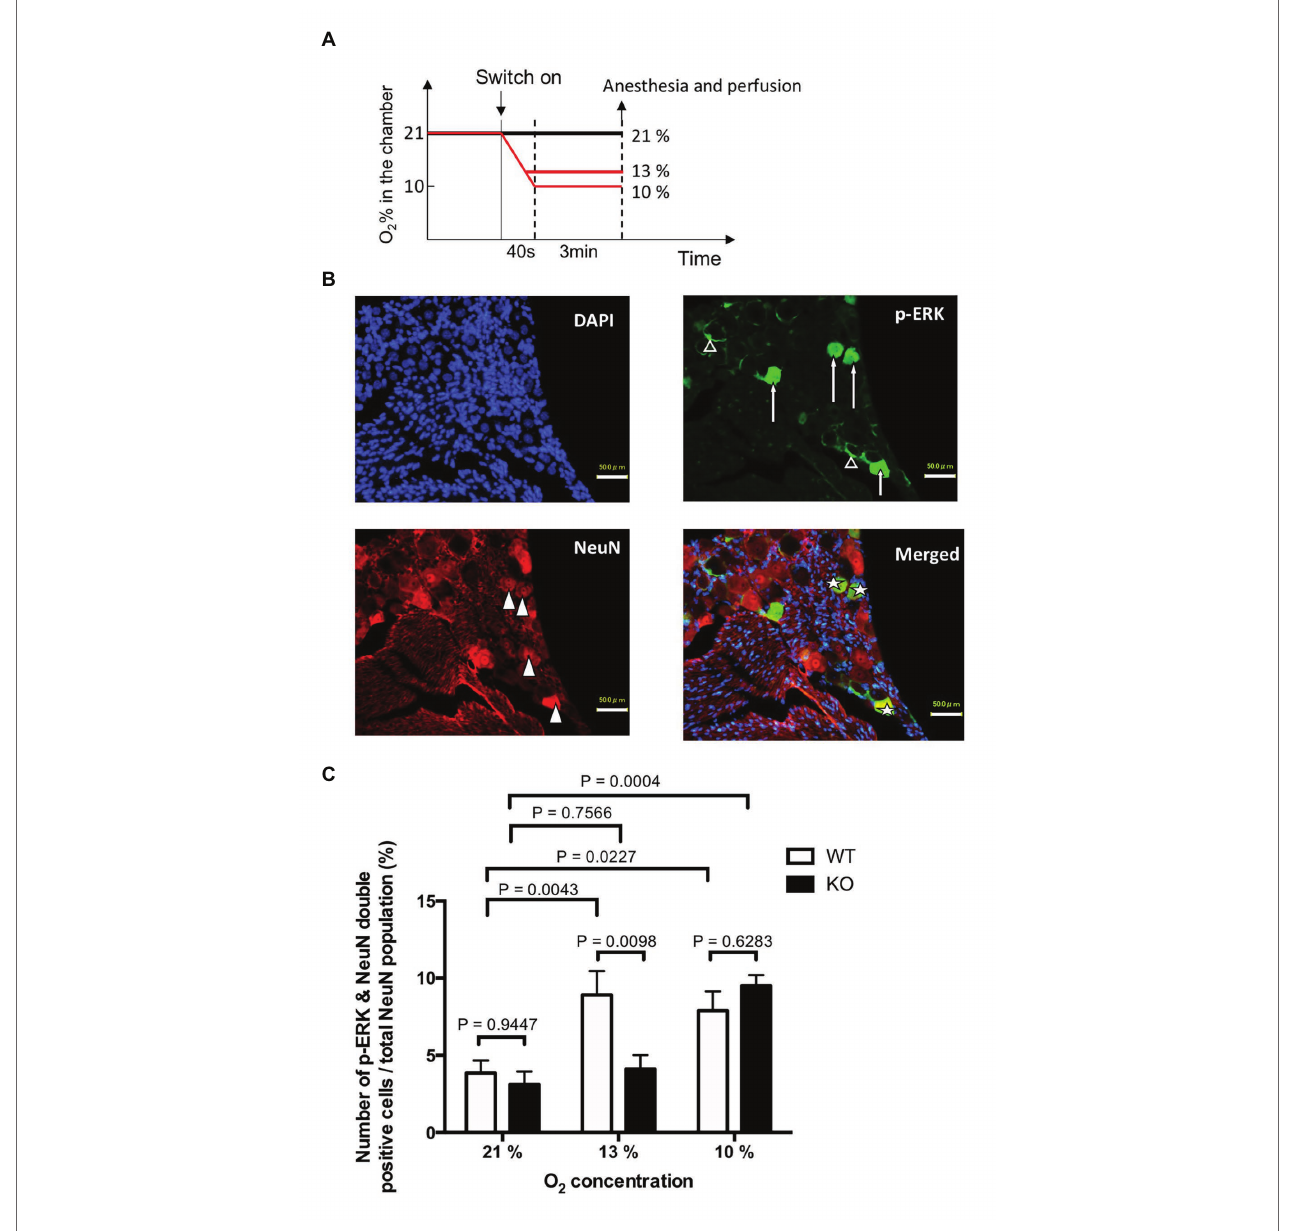
FIGURE 4 | Hypoxia induced activation of trigeminal ganglion neurons. (A) Experimental design. TRPA1-KO mice and WT mice were exposed to mild (13% O 2 ) or severe (10% O 2 ) hypoxia for 3 min, quickly euthanized, and then the trigeminal ganglion was sampled. Room air (21% O 2 ) was used as the control. (B) Typical example from WT mice that experienced 13% hypoxia. Note that p-ERK was positive in both neurons (arrows) and satellite cells (open triangles). (C) Ratio of p-ERK and NeuN double positive cells out of the total NeuN positive population. Each column represents mean and SEM in five animals. Two-way ANOVA revealed that there was a significant difference among O 2 concentrations ( F 2, 24 = 12.67, p = 0.0002) and interaction between O 2 concentration and genotype ( F 2, 24 = 4.882, p = 0.0166). Values of p in the figure were calculated by Sidak’s multiple comparison